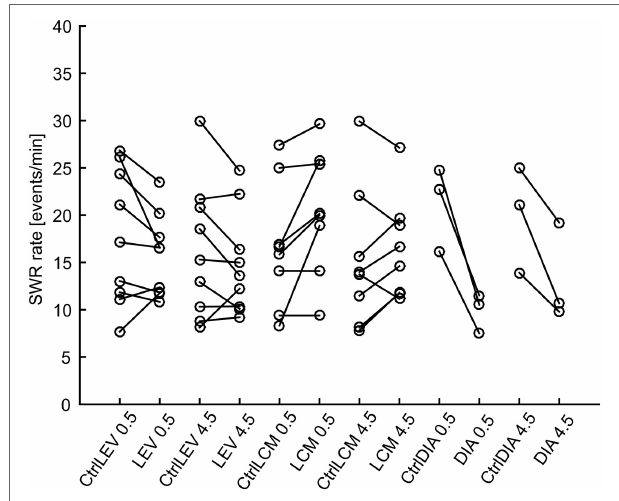
FigUre 2 | Sharp-wave ripple (SWR) rates after various treatments. Lines connect data points from individual animals. LEV, levetiracetam; LCM, lacosamide; DIA, diazepam; CtrlXXX, injection of equivalent volume of saline; 0.5, half an hour after injection, 4.5, four and half hours after